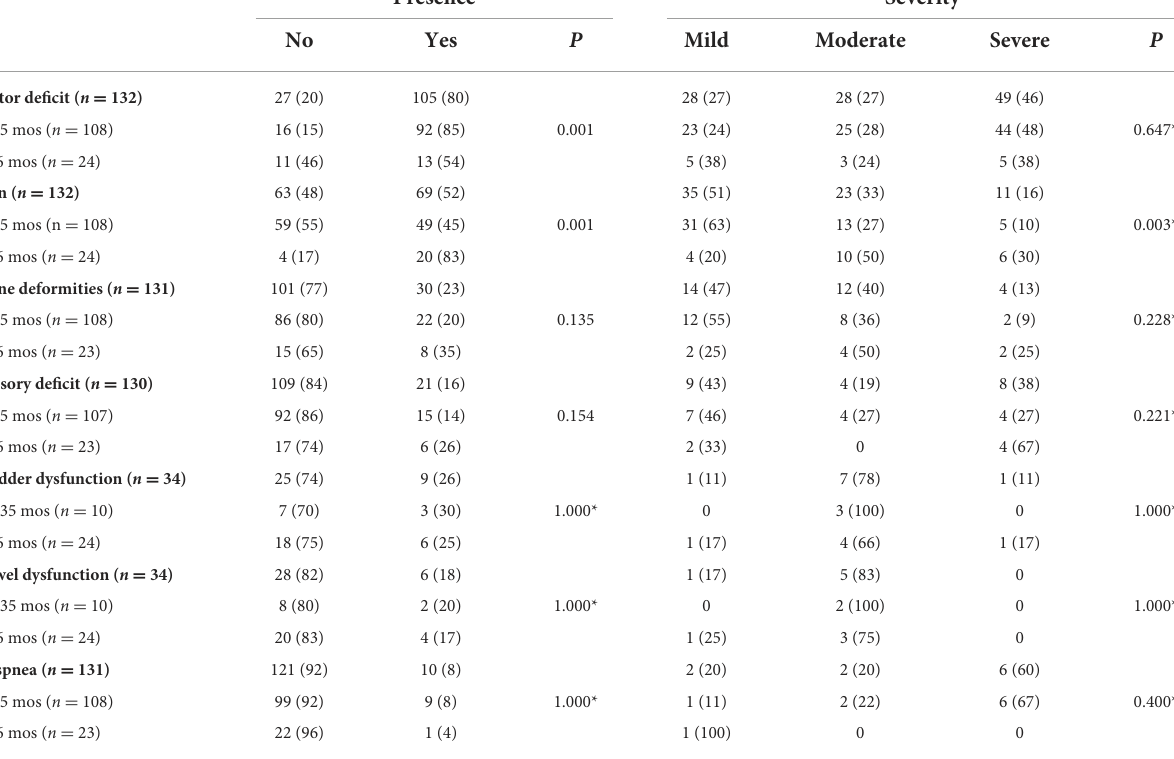
TABLE 5 SCI symptoms at presentation of 132 symptomatic patients in relation to